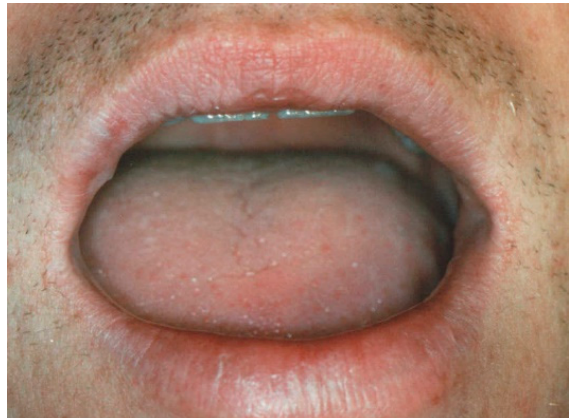
Figure 12. View of the healed area at 2 weeks post operation. The vaporization was performed using a CO 2 laser.